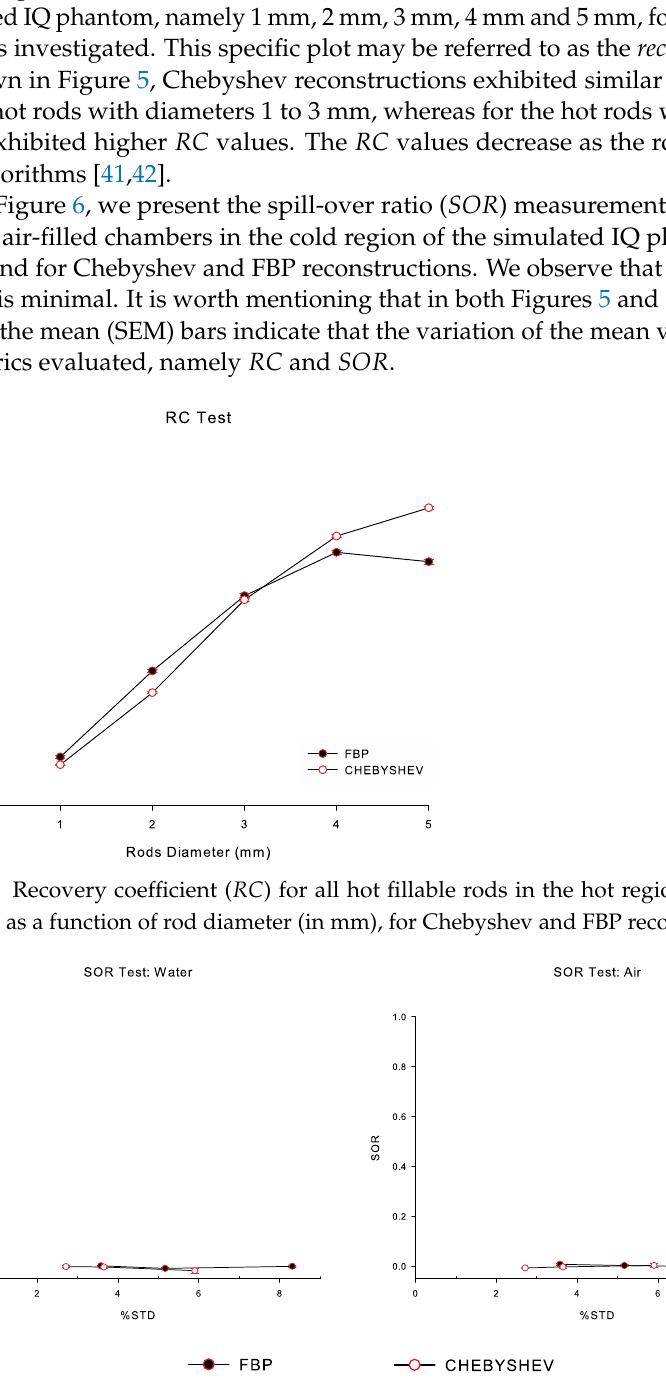
Figure 6. Spill-over ratio ( SOR ) measurements for the two water-filled and air-filled chambers in the cold region of the simulated IQ phantom, over the percentage standard deviation (% STD ), for Chebyshev and FBP reconstructions, corresponding to all noise levels. Note that the leftmost data point in each curve corresponds to NL1 (less noise), whereas the rightmost data point corresponds to the NL3